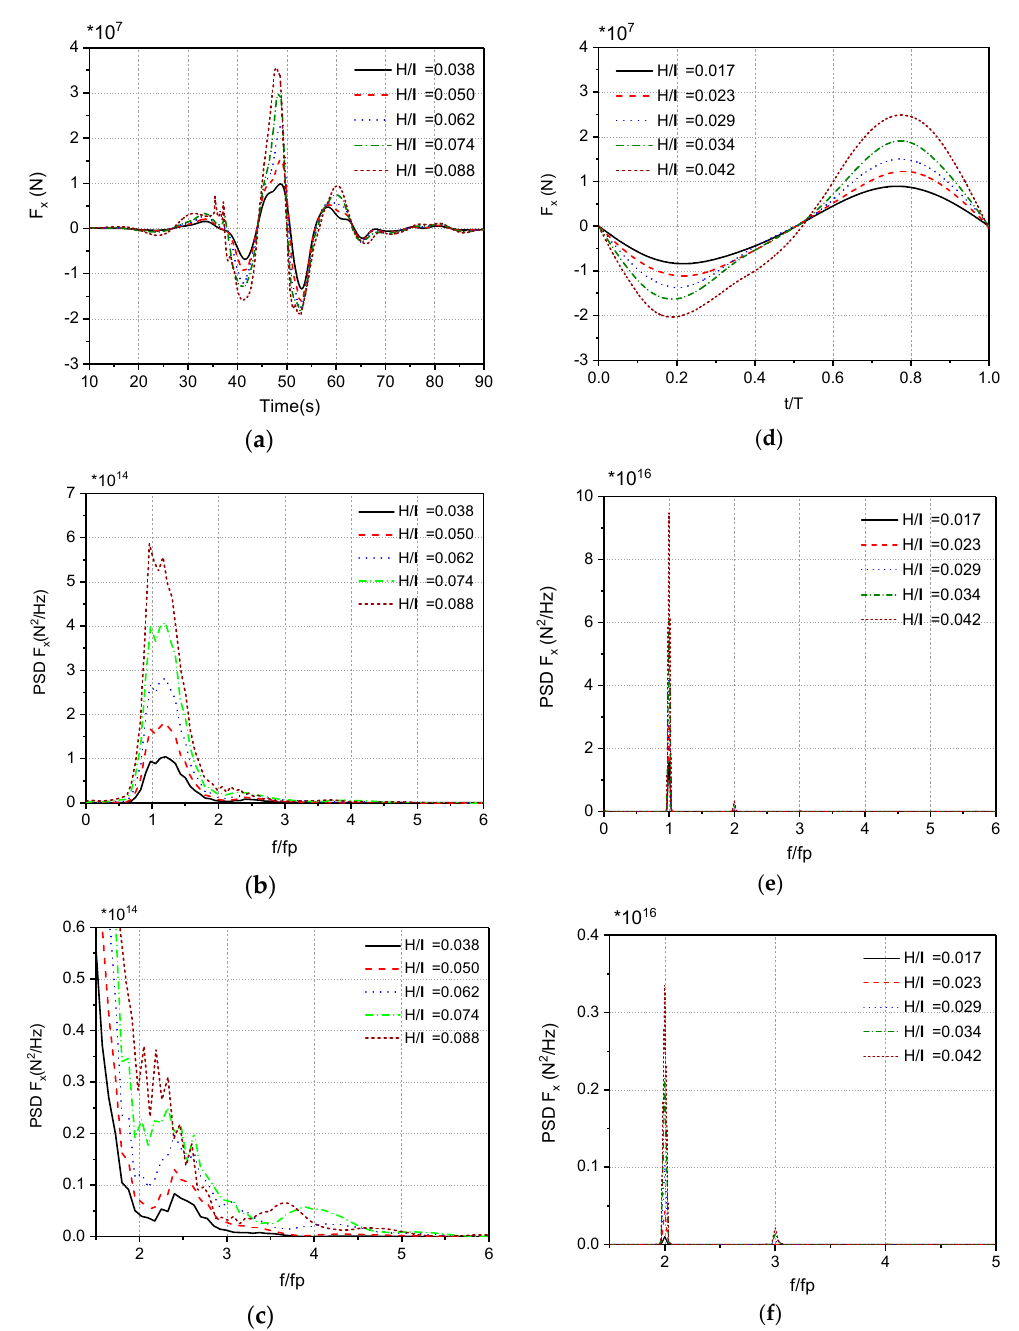
Figure 13. Power spectral density analysis (PSD) and the dimensional inline force F x under different wave steepness: ( a ) Fx under focused wave (Cases 1 to Case 5) ( b ) PSDs under focused wave (Case 1 to Case 5) ( c ) PSDs of higher-order under focused wave (Cases 1 to Case 5) ( d ) Fx under regular wave (Cases 6 to Case 10) ( e ) PSDs under regular wave (Case 6 to Case 10) ( f ) PSDs of higher-order under regular wave (Case 6 to Case 10). Table 7. Nonlinearity of regular wave.